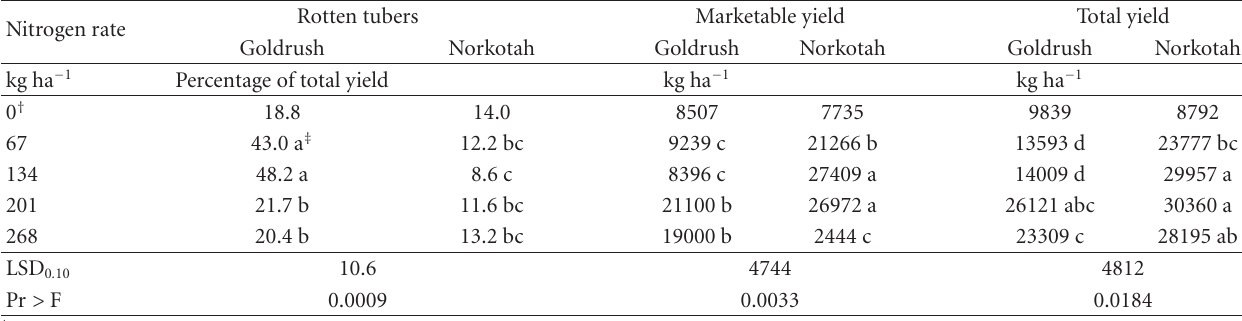
Table 7: Nitrogen rate × variety interaction in 2010 for rotten tubers as a percentage of total yield, marketable tuber yield, and total tuber yield for Russet potatoes grown on sandy loam soils in the Mid-Atlantic, averaged across N application timing.